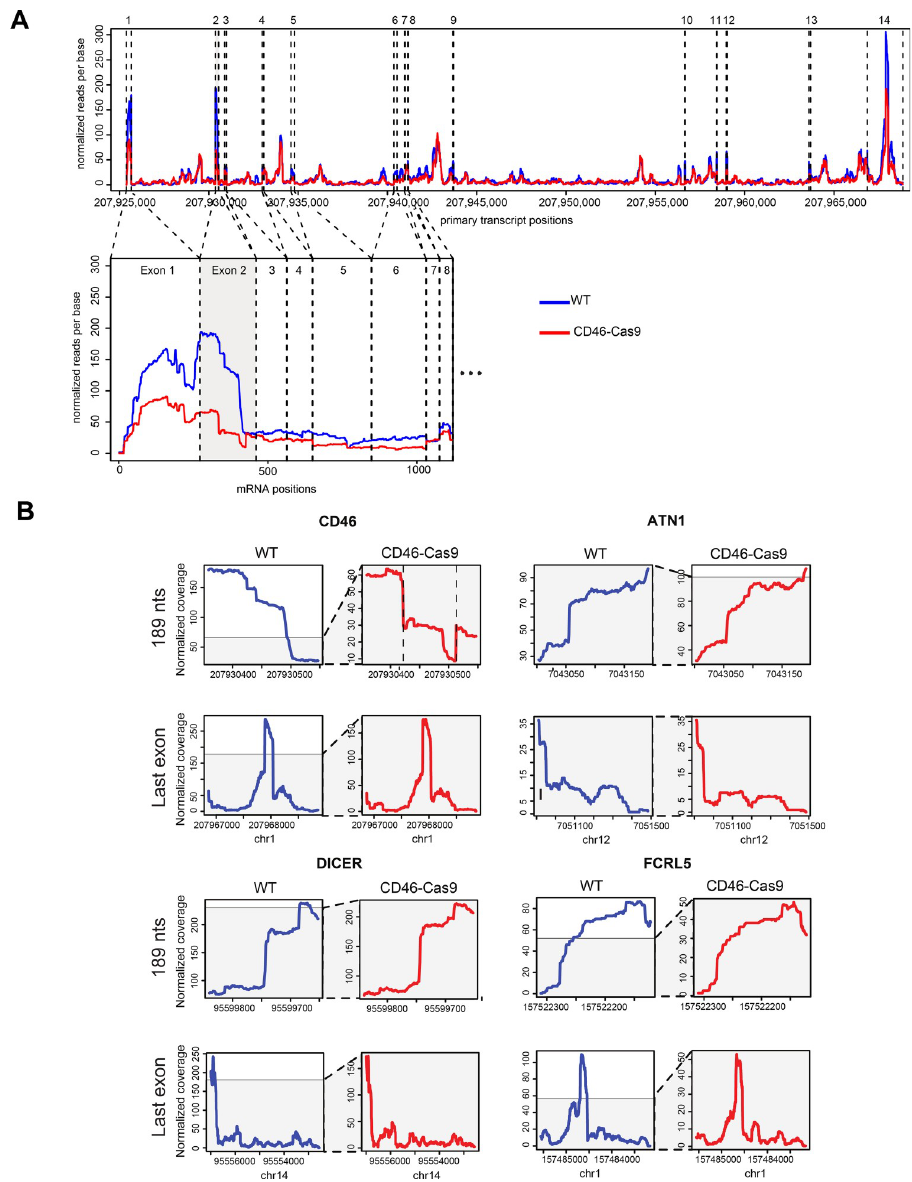
Fig 3. Read coverage of 4sU labeled transcripts shows a reduced transcription in cells 24 hours after CD46-Cas9 RNP complex nucleofection only at exon 1 and 2 of CD46. (A) The upper plot shows the primary, unspliced transcript of the CD46 gene together with its nucleotide coordinates on chromosome 1 and the 14 exons (dashed, vertical lines) of the CD46 transcript (x-axis). The normalized read coverage at single nucleotide resolution is shown (y-axis) from WT cells (blue line) and CD46-Cas9 treated cells (red line). The lower graph depicts the mRNA data of exon 1 to 8 of the CD46 transcript covering the two conditions. Read normalization of the three pairs of replicates was performed as stated in Materials and Methods. (B) The plots show the primary transcript positions (bp) (x-axis) vs. the normalized read coverage at single nucleotide resolution of four selected transcripts (CD46, ATN1, DICER, FCRL5). Transcript data (y-axis) from WT cells (blue line) and CD46-Cas9 nucleofected cells (red line) are shown. Plots indicated ‘189 nts’ visualize the 189 nt long exons of the ATN1, DICER and FCRL5 transcripts together with the second exon of the CD46 transcript. Plots of the last exons of the four transcripts are shown for comparison. The two dashed vertical lines in the plot of the second exon of CD46 indicate the positions of the Cas9 mediated cleavage sites.